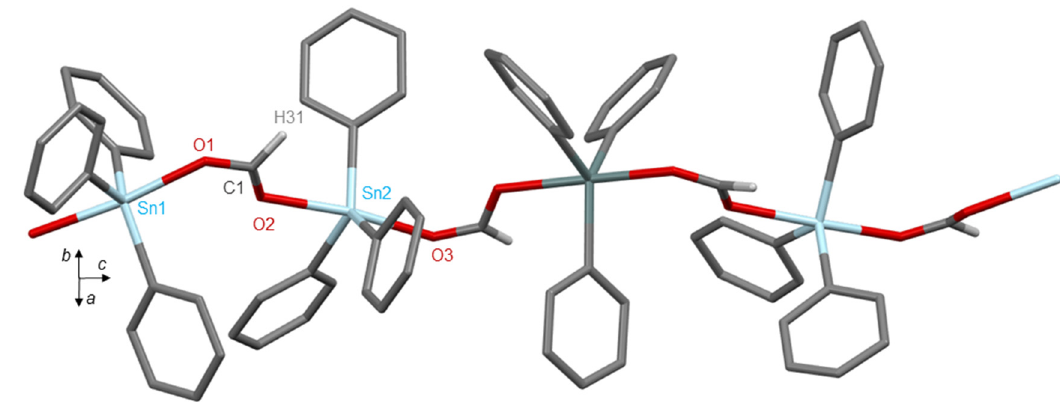
Figure 6. Molecular structure of [Ph 3 Sn(O 2 CH)] n (CSD refcode: FAJZIZ, 1151980), adapted from [58] (MERCURY view). Hydrogen atoms are omitted for clarity except that of the formate group (Sn light blue, O red, C grey, H white).